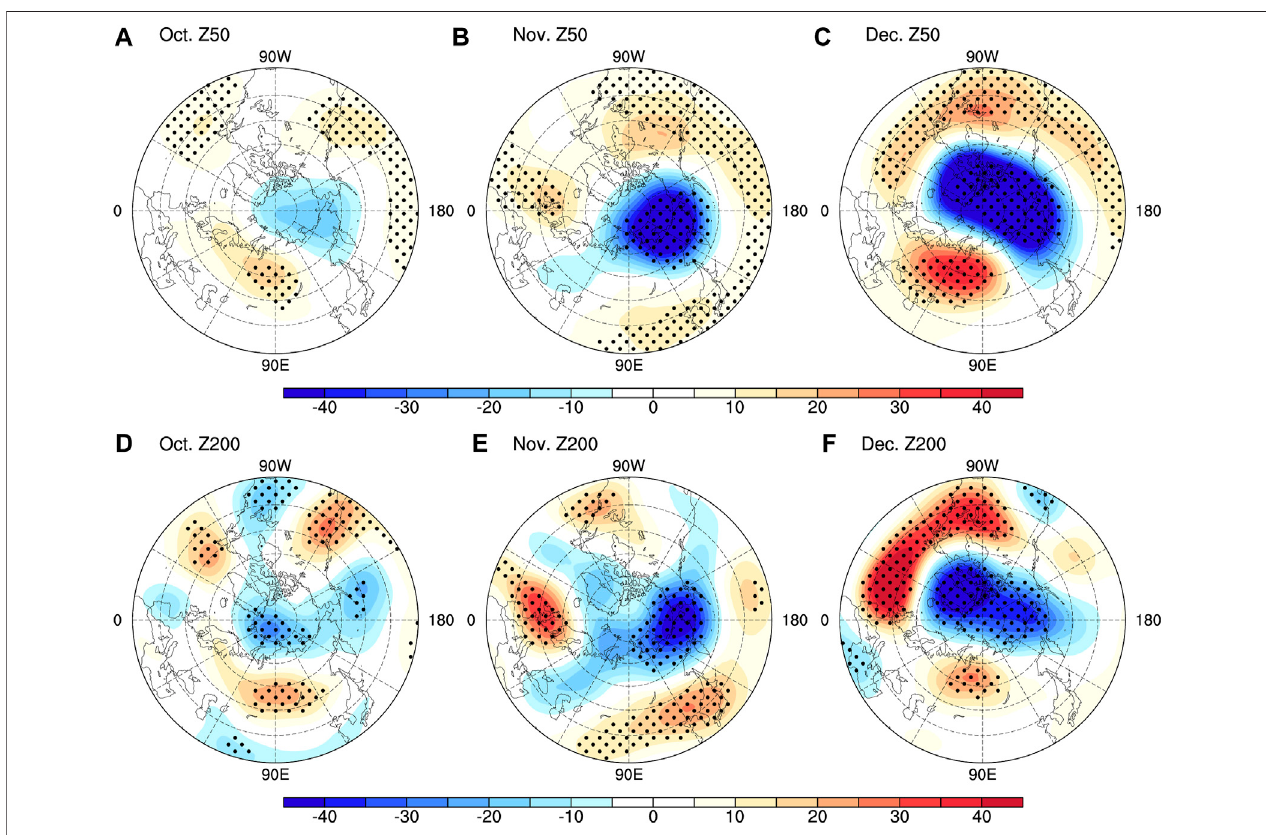
FIGURE 5 | Regressions of (A – C) 50 hPa geopotential height (m) and (D – F) 200 hPa geopotential height (m) in October, November and December against the negative October SNOWI during 1979 – 2017. Stippled regions indicate that the anomalies are signi fi cant at the 90% con fi dence level.